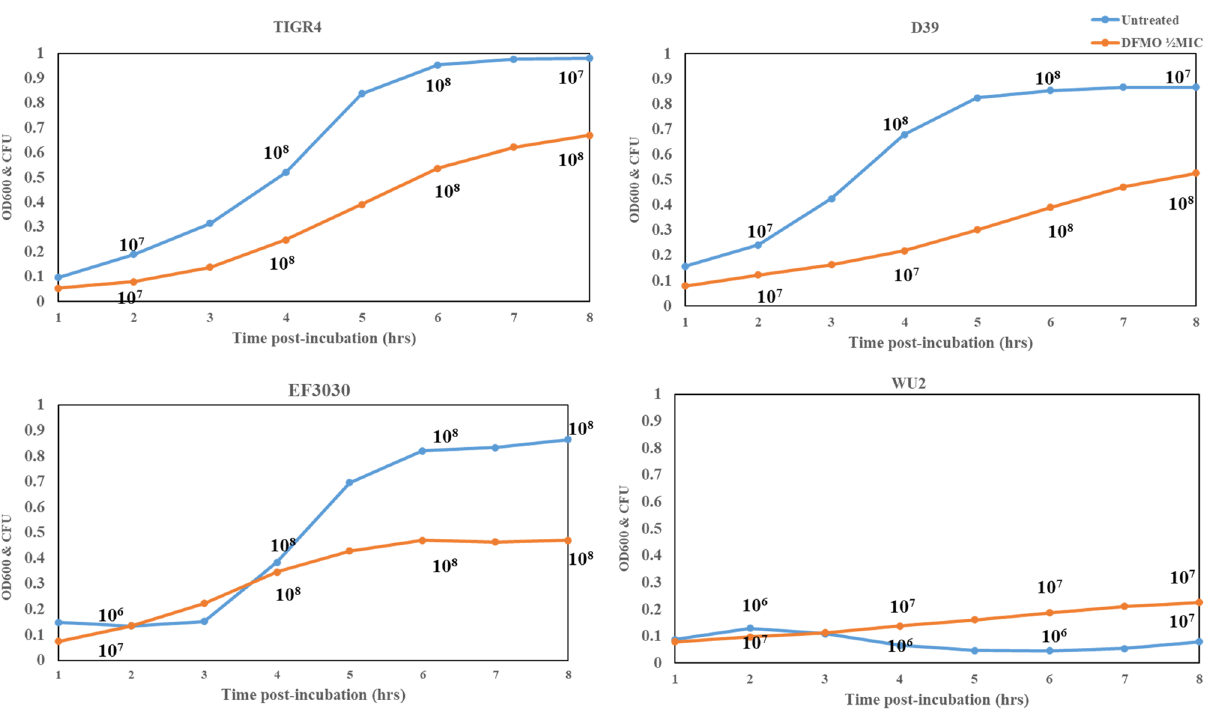
Figure 2. Impact of DFMO on pneumococci viability/replication. Optical density vs. colony forming unit (CFU/mL) of TIGR4, D39, EF3030 and WU2 treated with DFMO (orange, 1/2 MIC, 137 mM) with respect to the untreated (blue) show some bacteriostatic effect of DFMO in all serotypes except